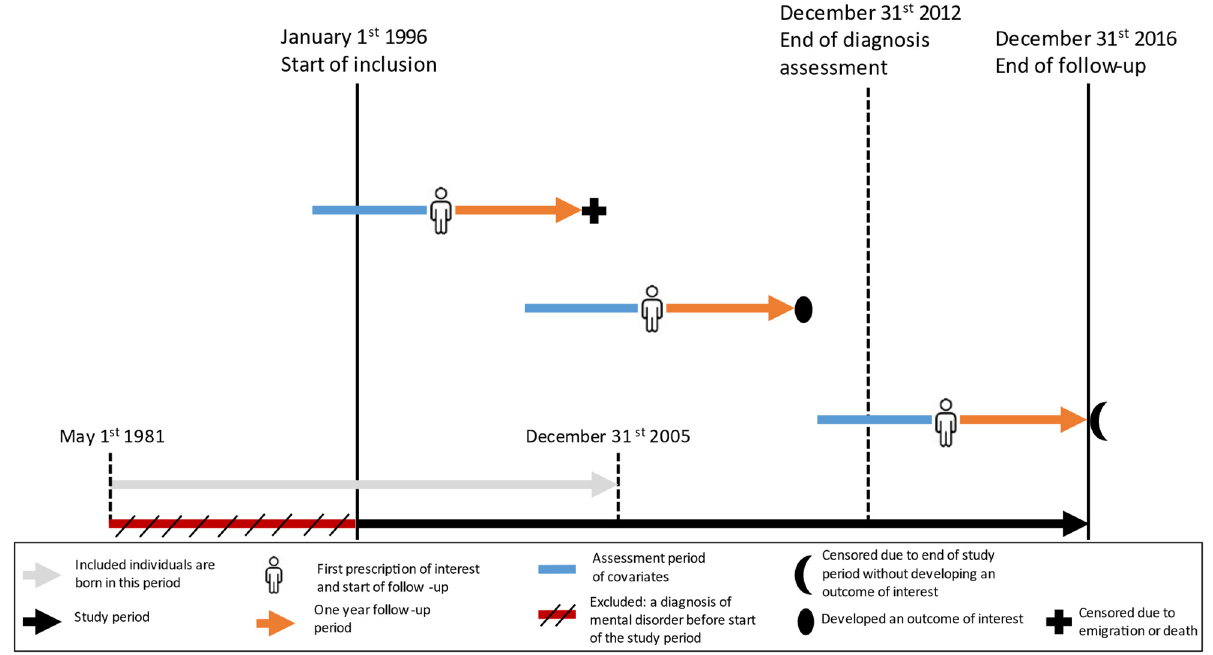
Figure 2. The selection of the study population, study design, and follow ‐